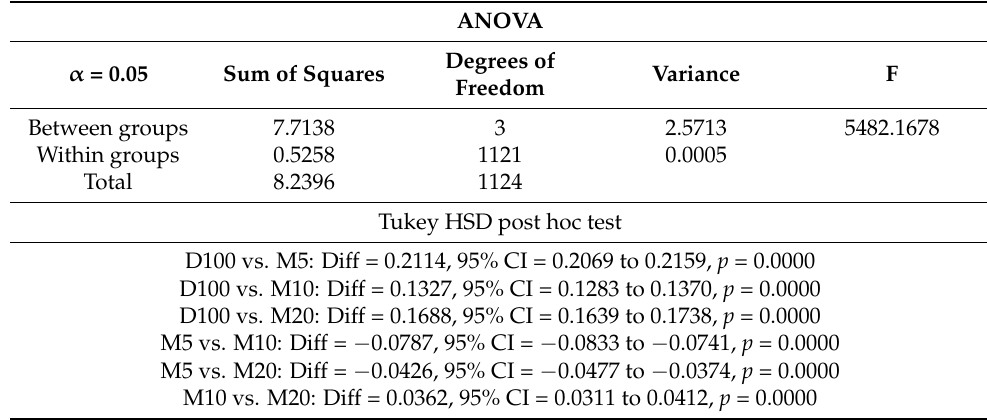
Table 9. Results of ANOVA with Tukey HSD post hoc test for CO at the measurement point 2.